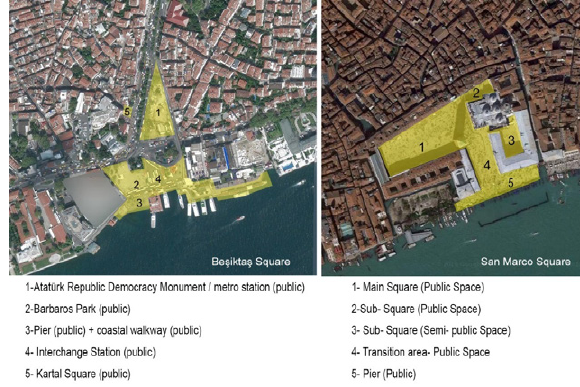
Figure 2. Sub-regions of the